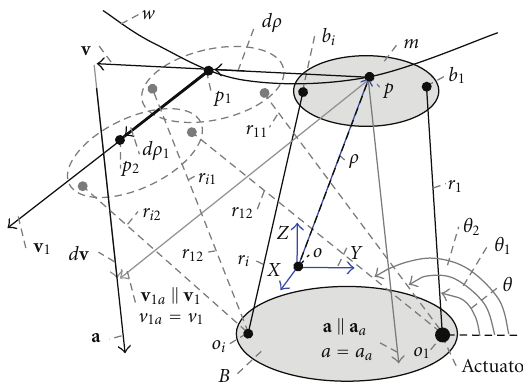
Figure 1: A general one-DoF